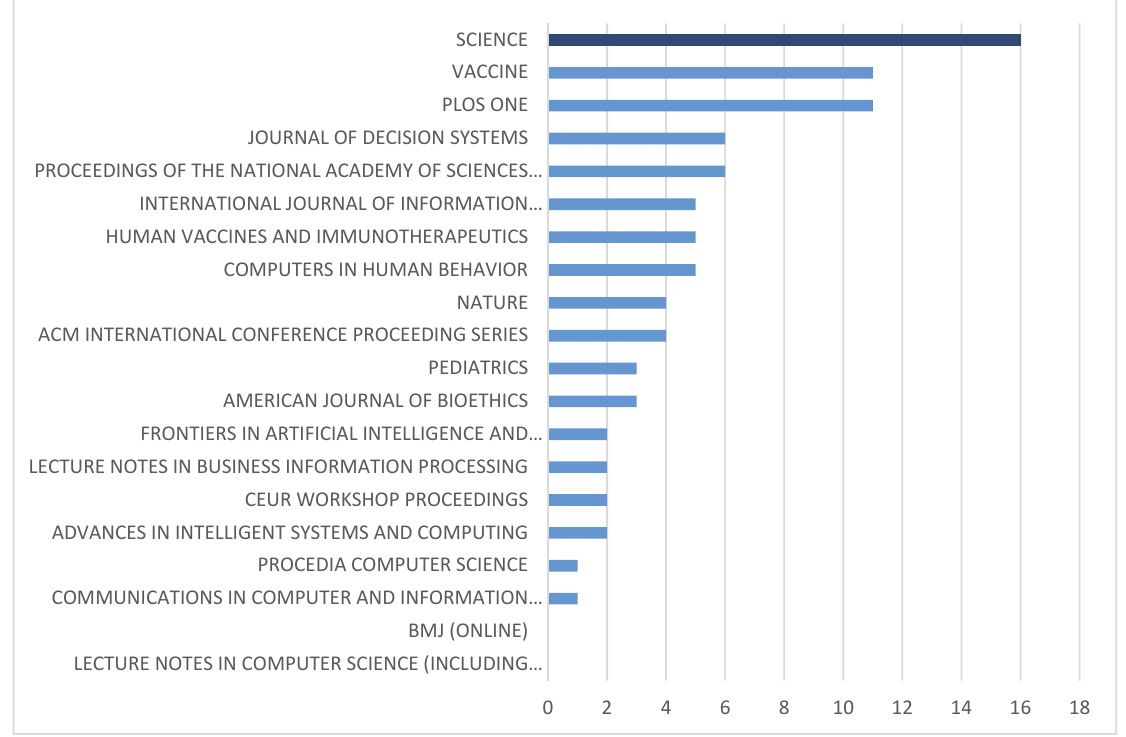
Fig. 2. Sources’ impact